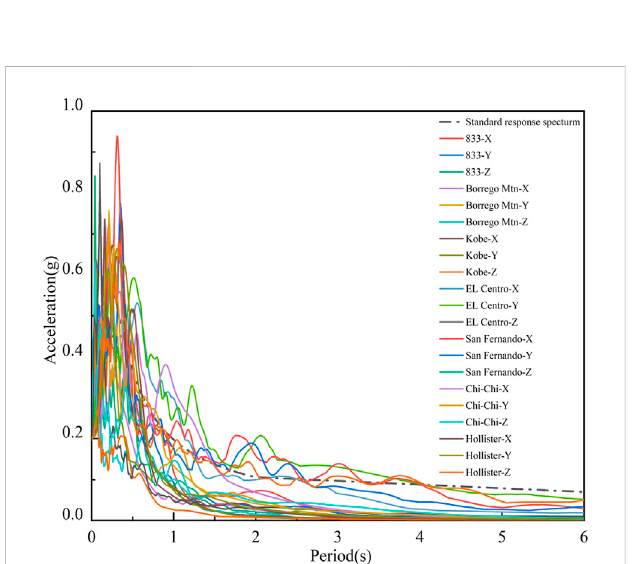
FIGURE 3 Earthquake response